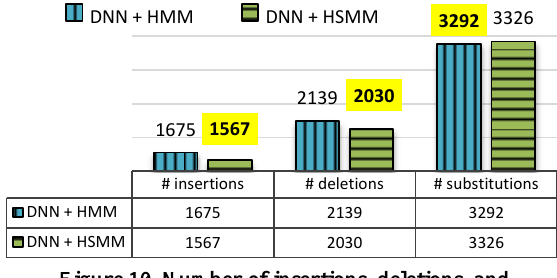
Figure 10. Number of insertions, deletions, and substitutions for HMM and HSMM